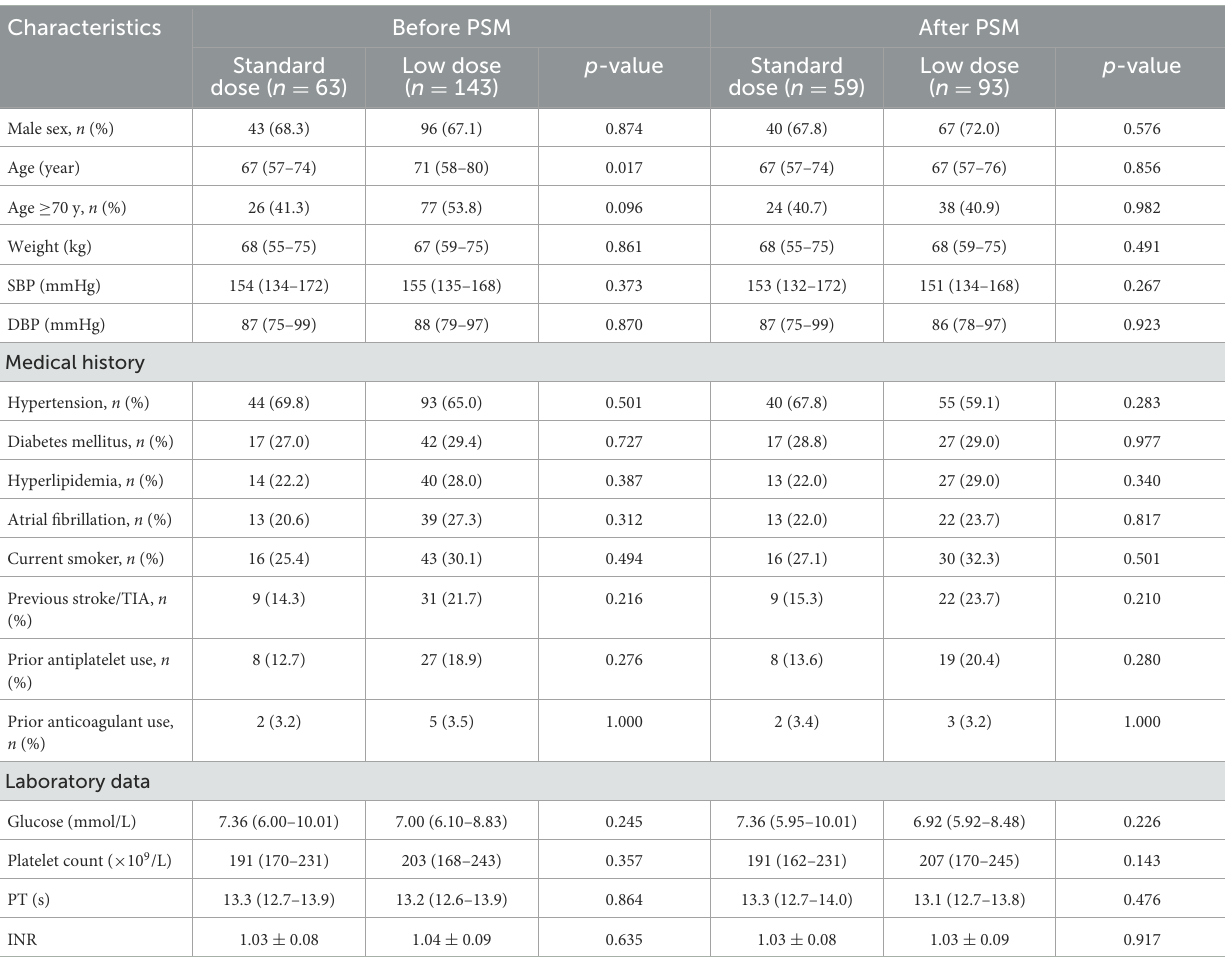
TABLE 1 Baseline characteristics of patients treated with standard- vs. low-dose alteplase before and after PSM.